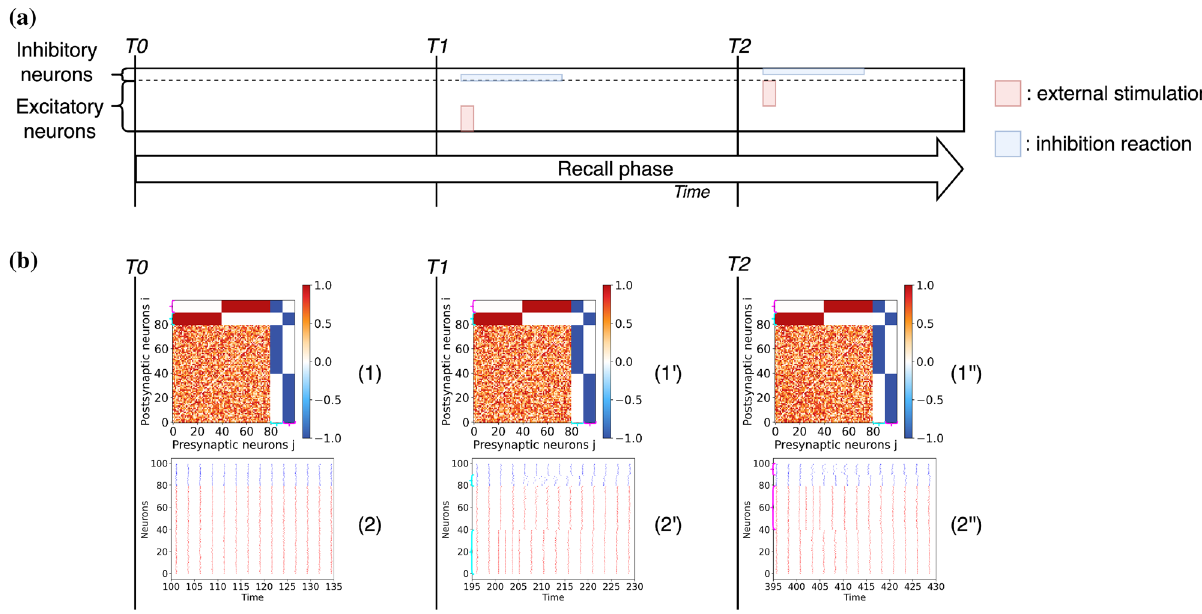
Figure 8. Memory recall experiment for a network of excitatory and inhibitory θ -neurons. ( a ) Schema of the pattern recall experiment. ( b ) The results are given at different instants of the simulation. The time T0 corresponds to the beginning of the simulation before the stimulations, after a transient period t t been discarded. Time T1 corresponds to a short stimulation of the first pattern (from time t t 205 ) followed by a recall response. Time T2 corresponds to a short stimulation of the second pattern (from = 400 to time t 405 ) followed by a recall of this one. The graphs have the same signification as in Fig. 3. time t = = The cyan and magenta brackets represent clusters 1 and 2 respectively when they are visible in weight matrices and raster